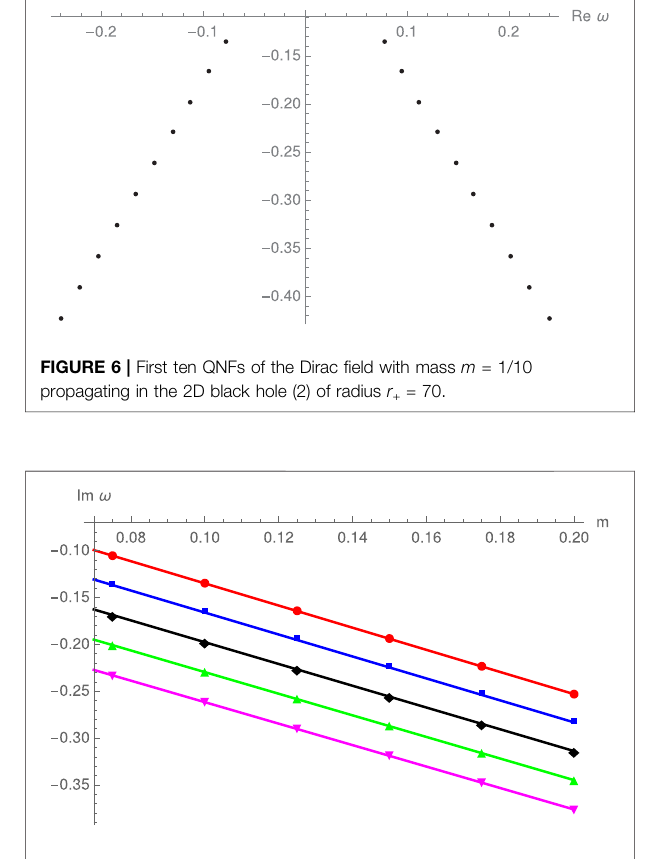
FIGURE 9 | For the fi rst five QNFs of the Dirac fi eld we show how the imaginary part depends on the radius of the 2D black hole (2). We consider a Dirac fi eld of mass m (cid:1) 1/10.